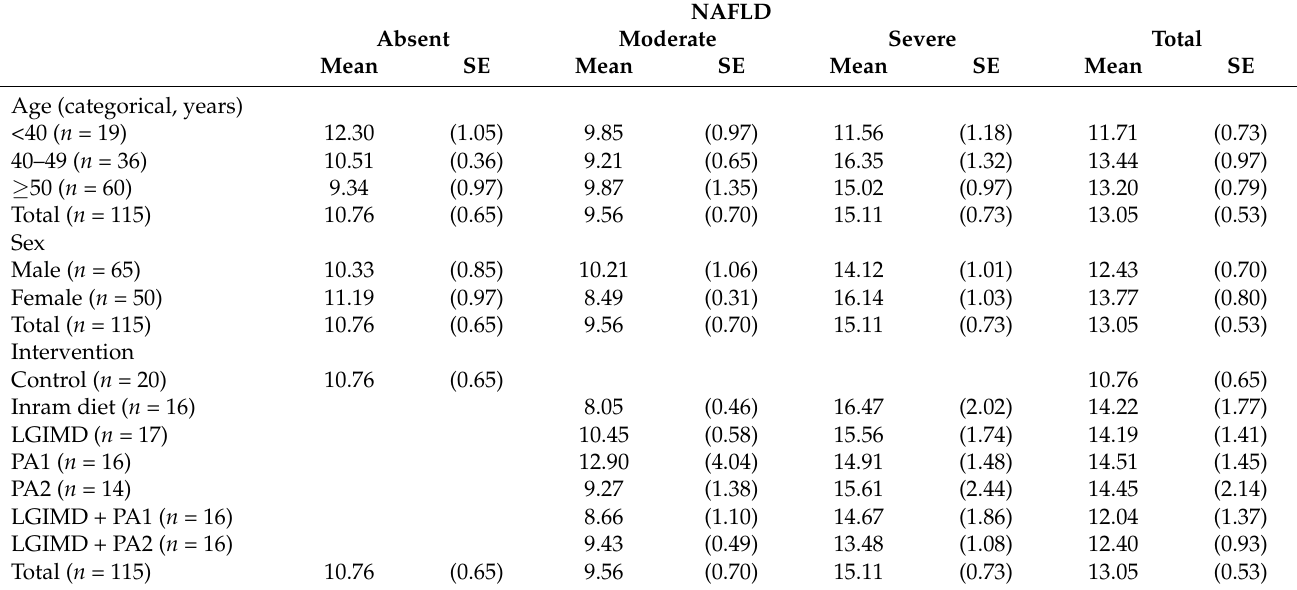
Table 1. Mean FZD7 expression by socio-demographic, intervention arm, and NAFLD severity. The control group consisted of 20 people, the Inram diet group consisted of 16 subjects, the LGIMD group consisted of 17 subjects, the PA1 group consisted of 16 subjects, the PA2 group consisted of 14 subjects, the LGIMD + PA1 group consisted of 16 subjects, and the LGIMP + PA2 group consisted of 16